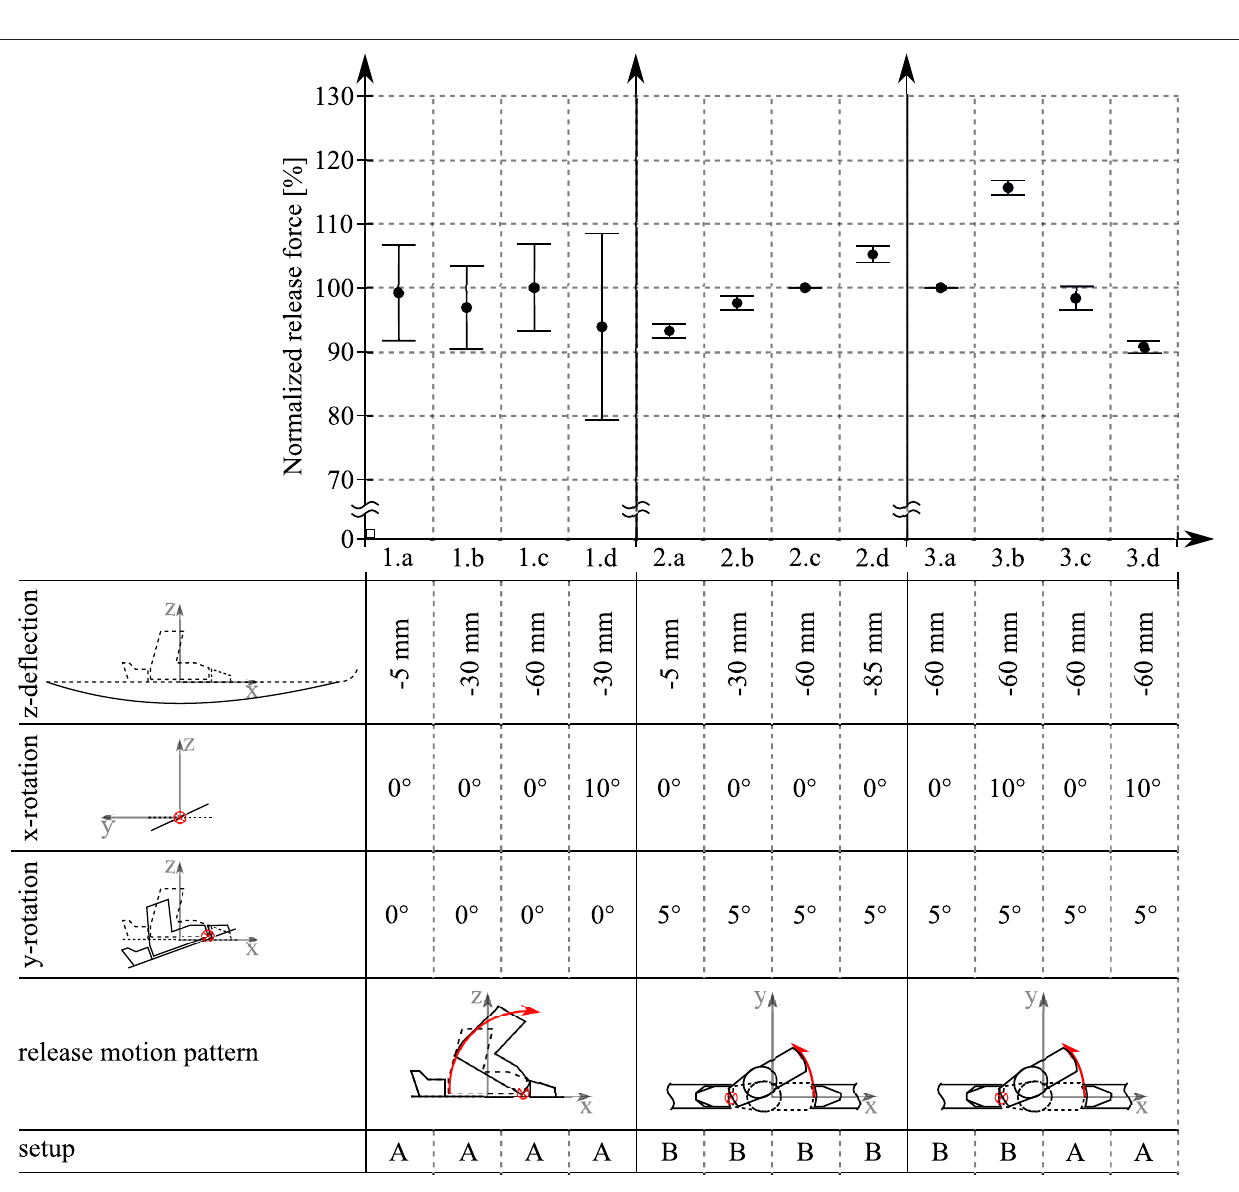
FIGURE 6 | Release forces and 95% level of confidence for different release motion